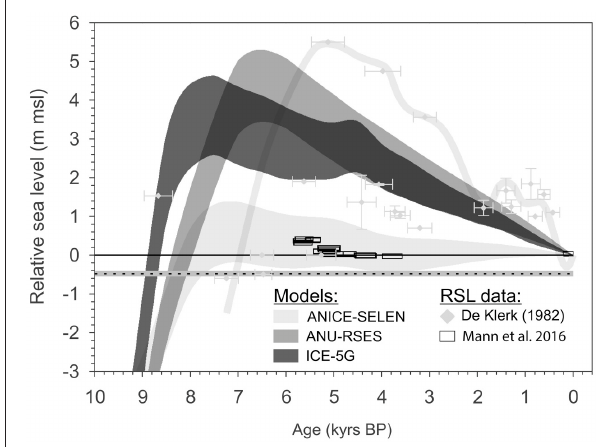
FIGURE 5 | Holocene relative sea-level curves for the Spermonde Archipelago based on geophysical model predictions from Lambeck (1998), Peltier (2004), and De Boer et al. (2014a,b), field observations from De Klerk (1982) and surveyed fossil microatolls from Mann et al. (2016a). Differences between the two data sets are explained by the different methodological approaches (Mann et al., 2016a). Fossil microatolls have relatively low positional uncertainties and a precise indicative meaning, especially when their elevations can be compared against their living analogs. Multi-proxy approaches, where different sea-level markers are combined into a single relative sea-level curve, are rather prone to misinterpretations (Adopted and modified from Mann et al. (2016a), reproduced with permission from